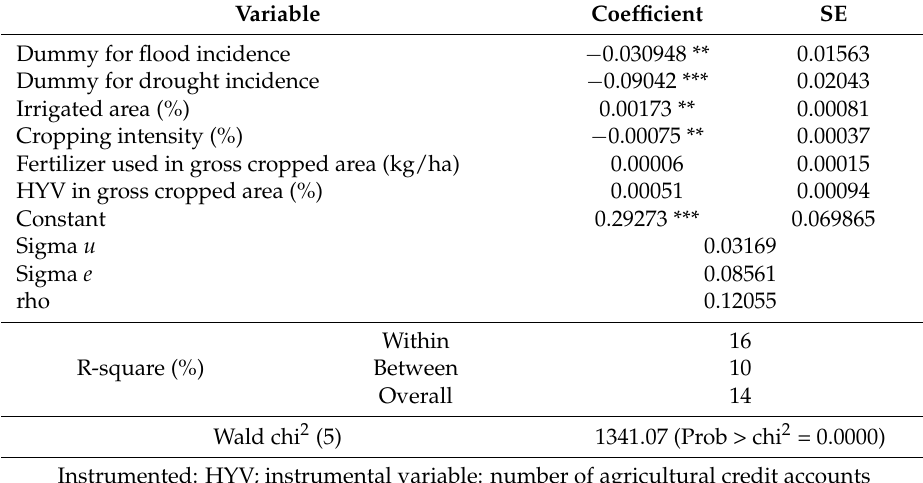
Table 3. Influence of different factors on WP (results of the fixed effects two-stage least square model). Variable Coefficient SE Dummy for flood